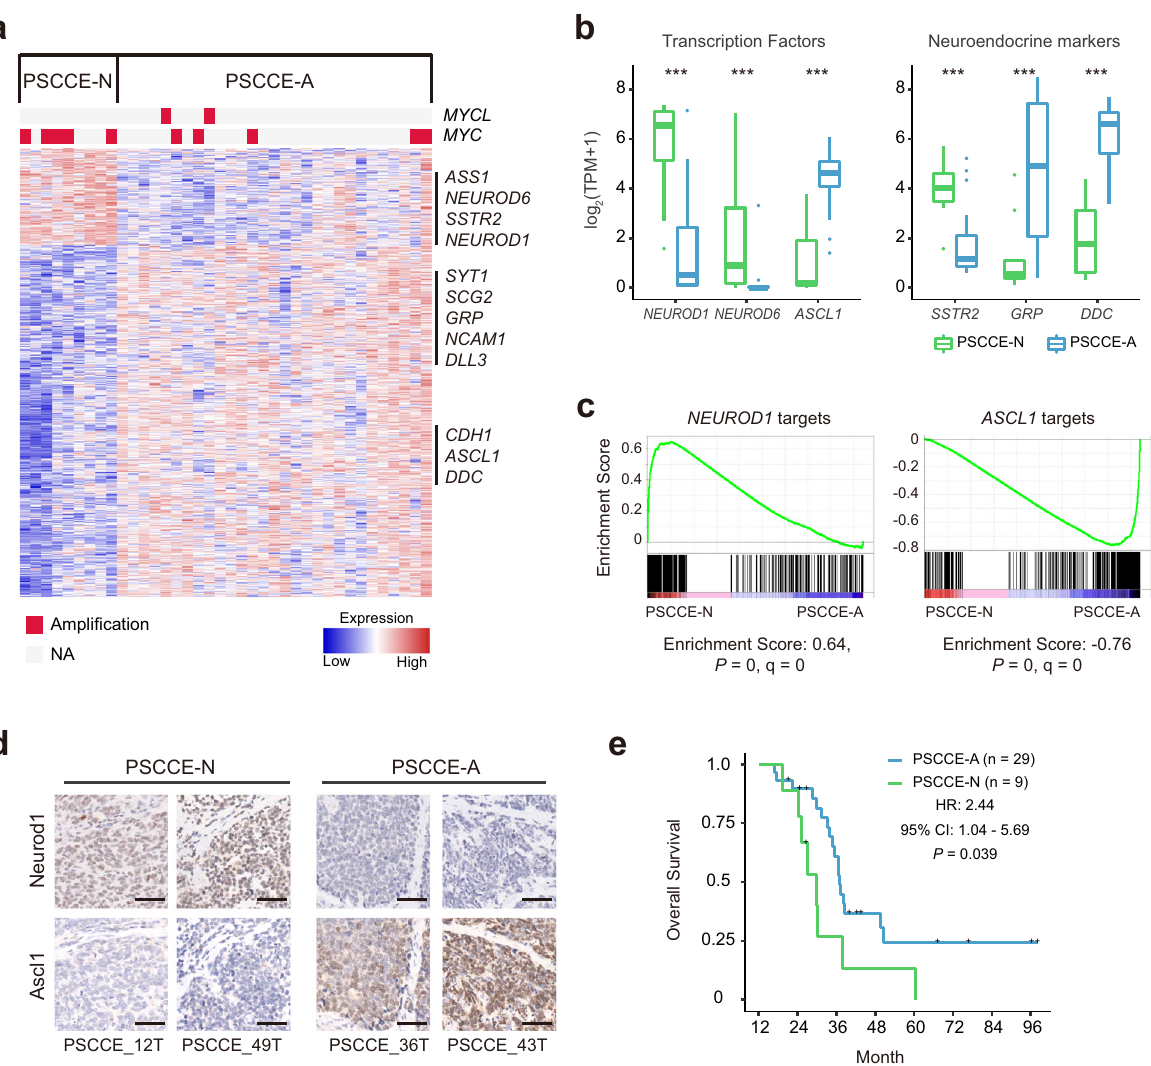
Fig. 4 PSCCE had two molecular subtypes. a Gene expression heatmap of PSCCE-A and PSCCE-N subtypes identi fi ed by unsupervised consensus clustering. Ampli fi cations of MYC family are shown on the top of the heatmap. Selected key genes related to subtyping are shown on the right side. NA: no signi fi cant SCNV observed. Source data are provided as a Source Data fi le. b Expressions of lineage transcription factor and neuroendocrine marker genes that were signi fi cantly differentially expressed across two subtypes. The upper bound, centerline, and lower bound of boxplot represent the 75 percentile, the median and the 25 percentile of data; the upper and lower whiskers extend to the largest and smallest value within 1.5 times of IQR from corresponding bound. Data beyond the whiskers are plotted as outlier dots. *** P < 0.001, by the Wilcoxon rank-sum test. c GSEA revealed that target genes of NEUROD1 and ASCL1 were preferentially expressed in PSCCE-N and PSCCE-A subtype. d IHC of Neurod1 and Ascl1 showed inverse expression pattern in PSCCE-N and PSCCE-A subtypes. Scale bar: 50 μ m. e Kaplan – Meier plot of the overall survival of patients from two